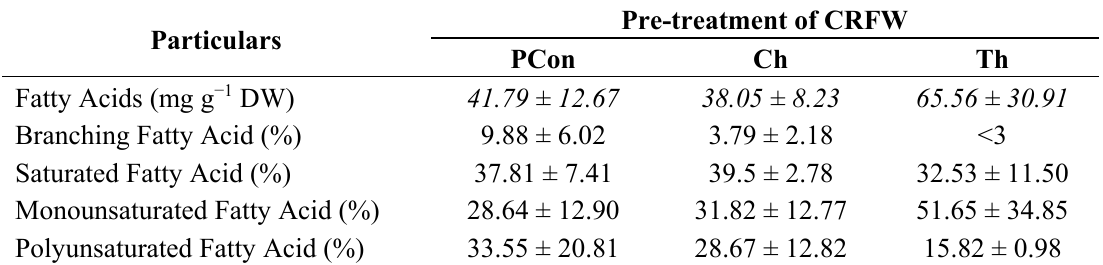
Table 1. Total fatty acid contents and distribution of fatty acid categories in R. glutinis cultivated in CRFW